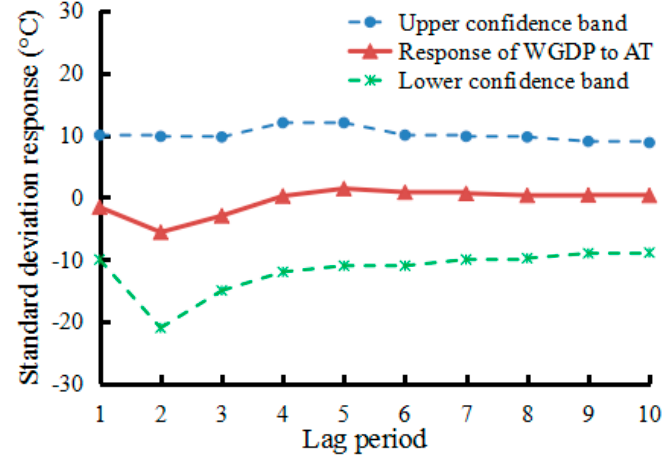
Figure 1. Standard deviation response of WGDP to AT.